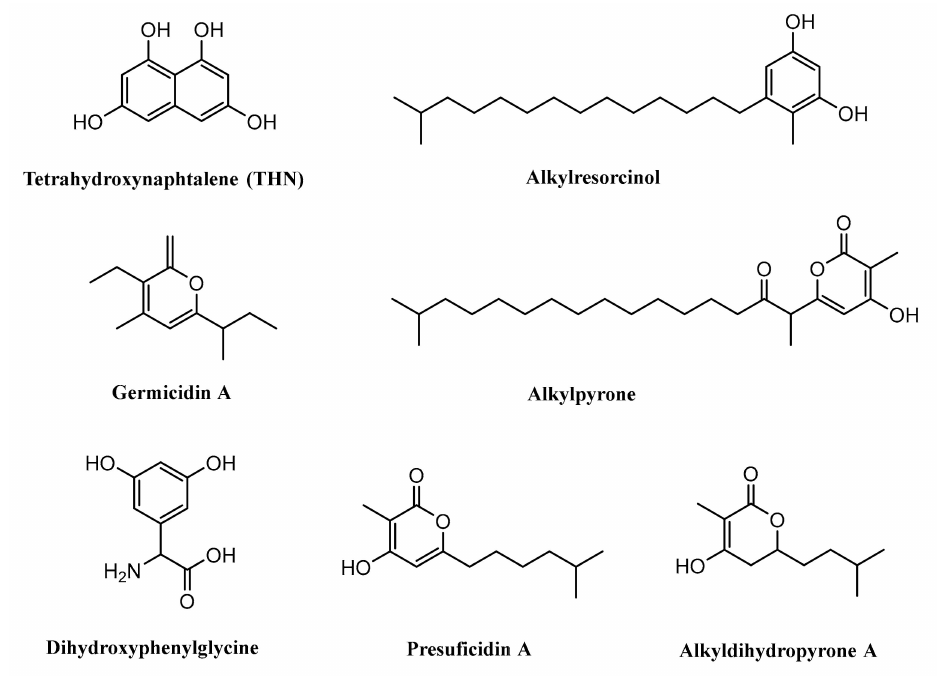
Figure 7. Some compounds produced by type III